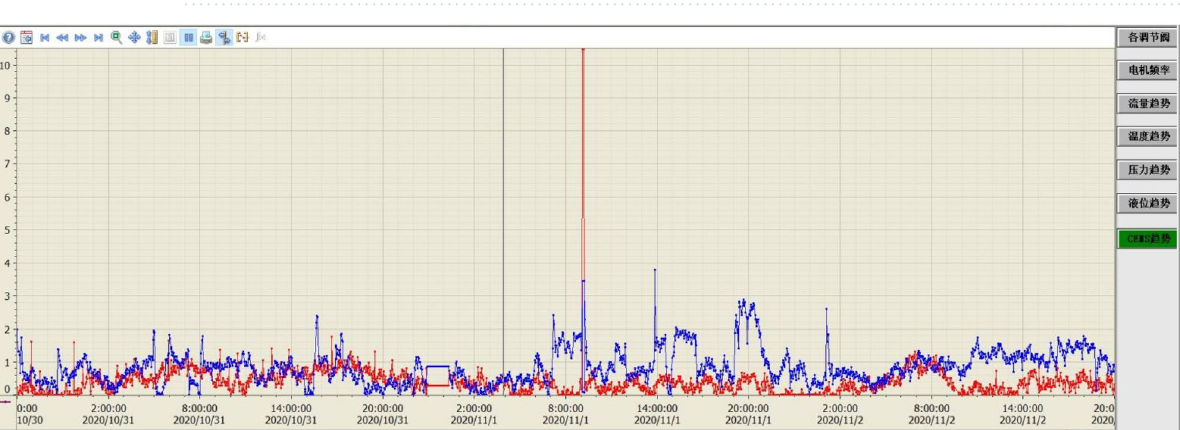
Figure 16. SO 2 (red) and NO x (blue) concentration of inlet flue gas during 72-h operation.